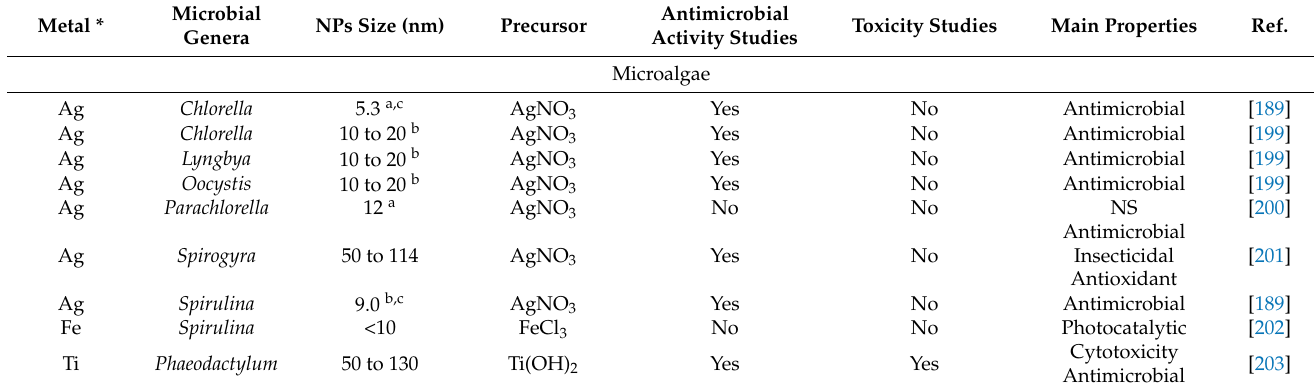
Table 3. Biosynthesis of metal nanoparticles using microalgae. Several examples of literature published in the last five years (2018–2022). The microbial genera, the metal and its precursor and the size of the metal nanoparticles obtained are presented. It is also stated whether the antimicrobial activity and toxicity of the nanoparticles were tested and which properties were